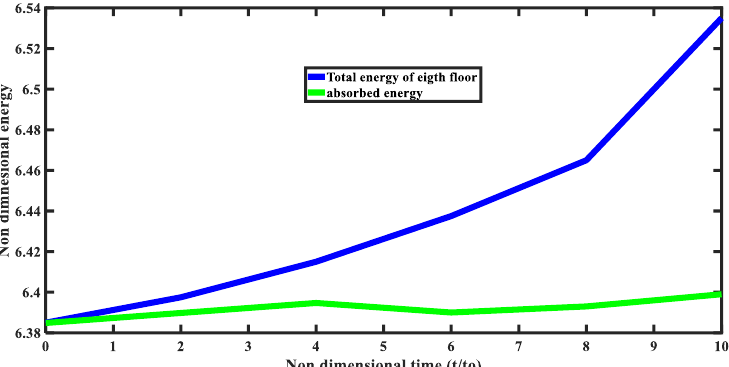
Fig. 13. Absorption of non-dimensional energies and non-dimensional time by cladding